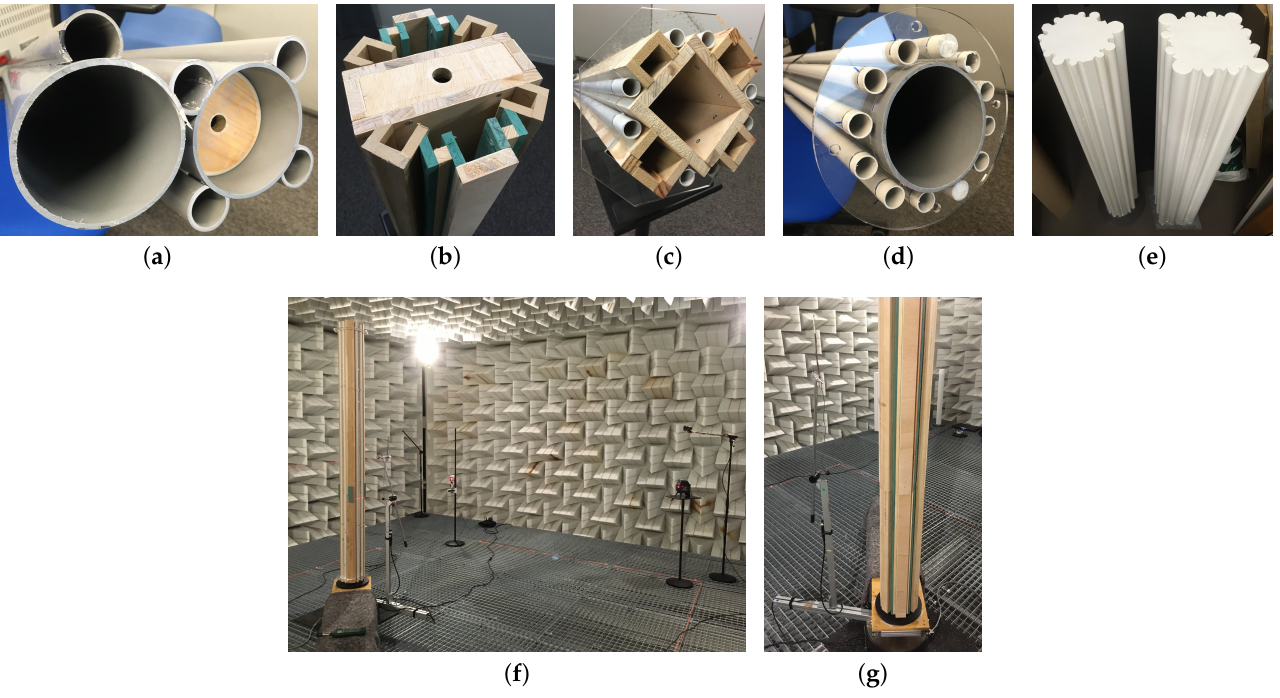
Figure 5. Photographs of scale models and experimental set-up. Piers and columns: ( a ) N2 and N1 , ( b ) C1 , ( c ) C2 , ( d ) N3 , and ( e ) Ch and T . Experimental set-up: ( f ) overview with the sound source on the right, ( g ) view of the platform, turntable, and microphone mounted on an articulated